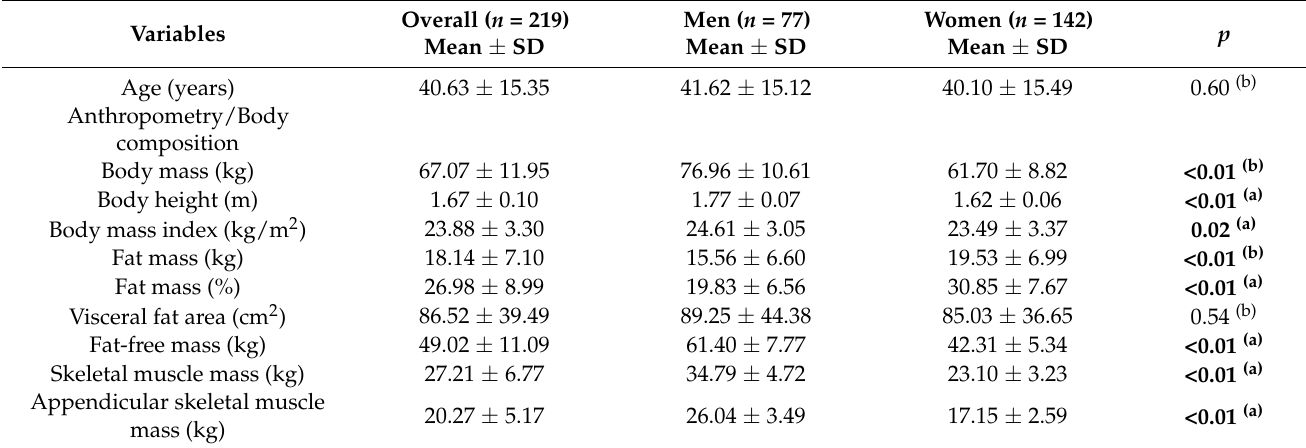
Table 1. Baseline characteristics of study